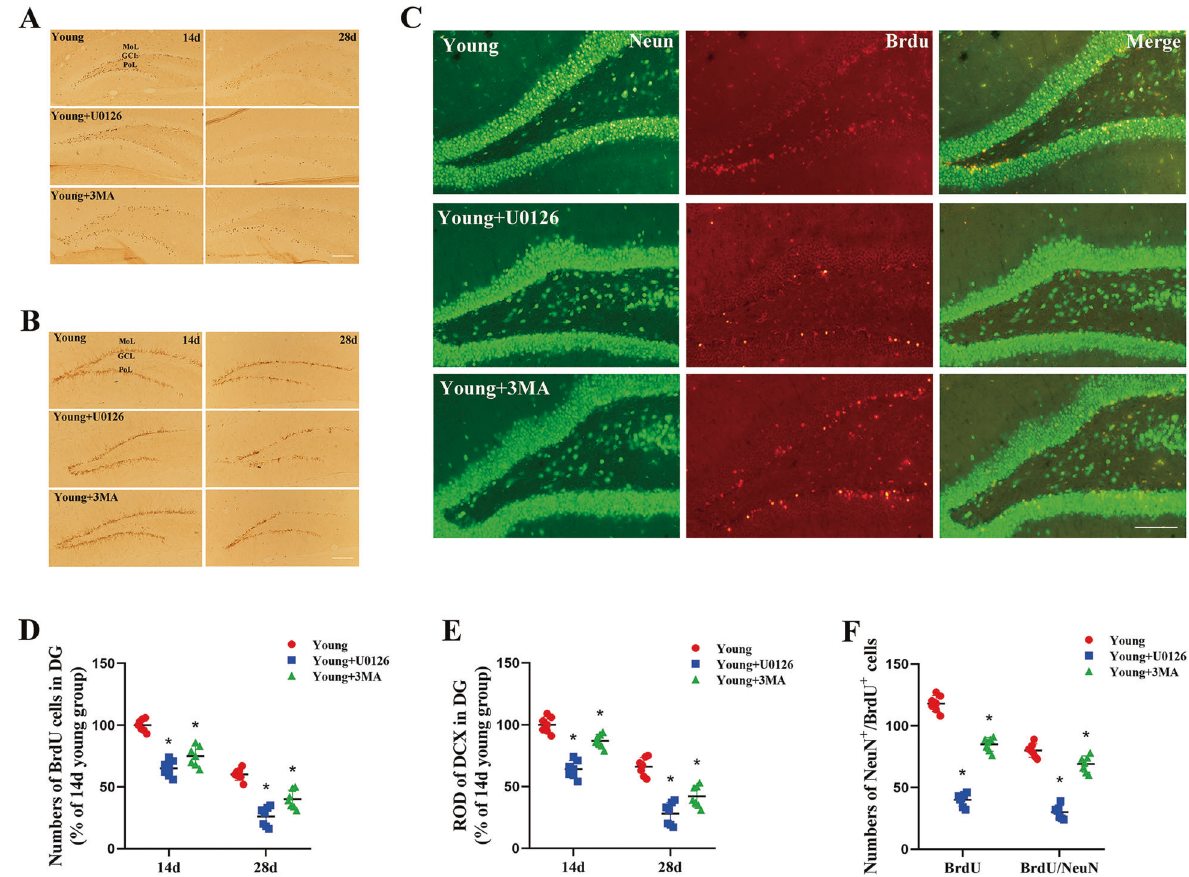
Fig. 5 Change of Cell proliferation and neuroblast differentiation by U0126 or 3MA treatment. Immunohistochemistry for BrdU in the DG region of the young gerbils treated with U0126 or 3MA after I/R ( A ). Immunohistochemistry for DCX in the DG region of the young gerbils treated with U0126 or 3MA after I/R ( B ). Double-immuno fl uorescence staining for BrdU, NeuN, and merged images in the DG 28 days after I/R in the young gerbils treated with U0126 or 3MA ( C ). The number of BrdU cells after I/R in the young gerbils treated with U0126 or 3MA. Data are represented by the mean number of BrdU cells per animal ( D ). Relative optical density as % of DCX immunoreactive structures in the young gerbils treated with U0126 or 3MA ( E ). Quanti fi cation of BrdU/NeuN cells at 28 days post ischemia. Data are represented by the mean percentage per animal ( F ). Scale bar = 100 μ m ( n = 7 per group; * p < 0.05, signi fi cantly different from the young group at the same reperfusion time). Bars indicate mean ±